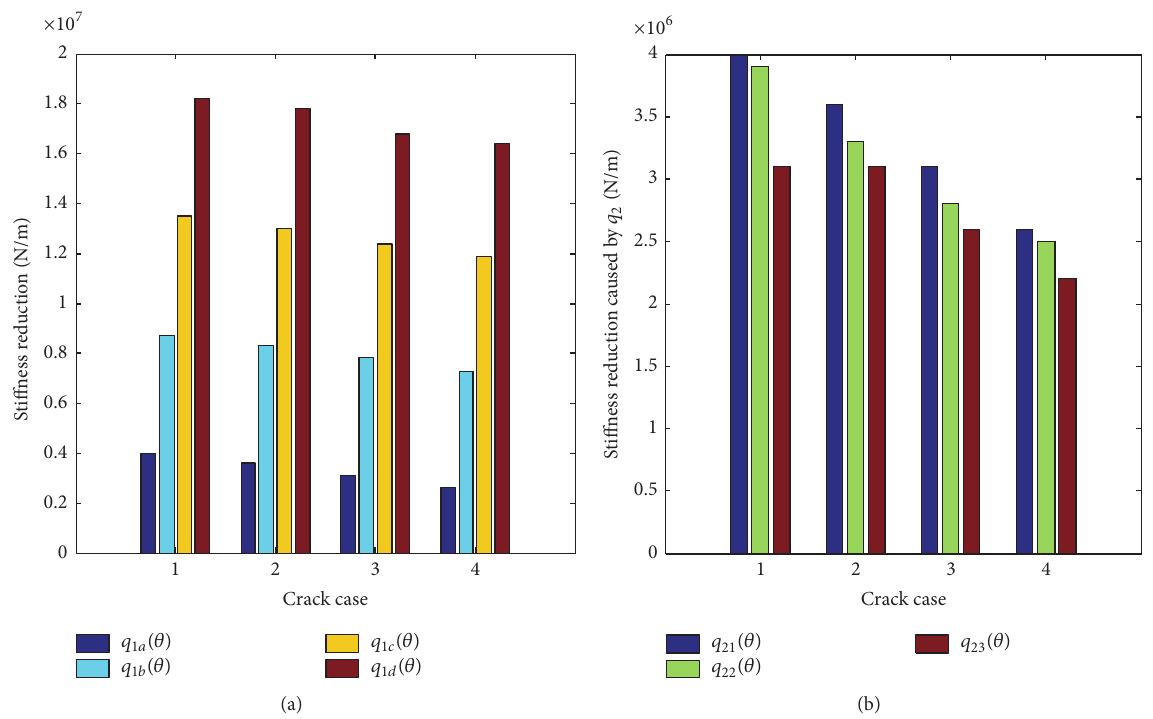
Figure 7: Mesh stiffness reduction caused by TCOP models in all